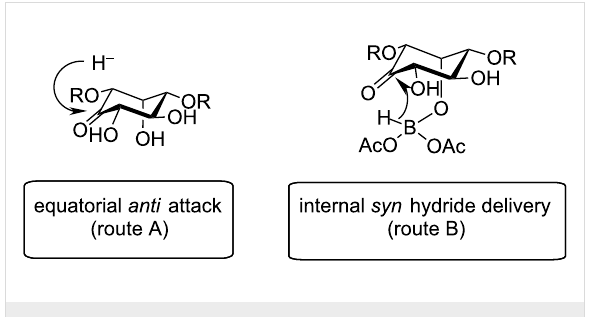
Figure 3: Stereoselective reduction of inosose